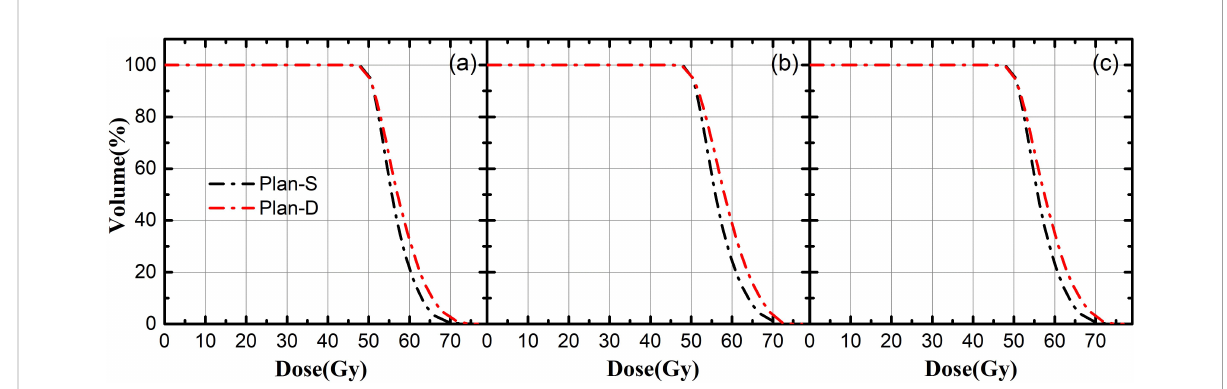
Table 3. Compared with the Plan D, the coverage of PTV1,